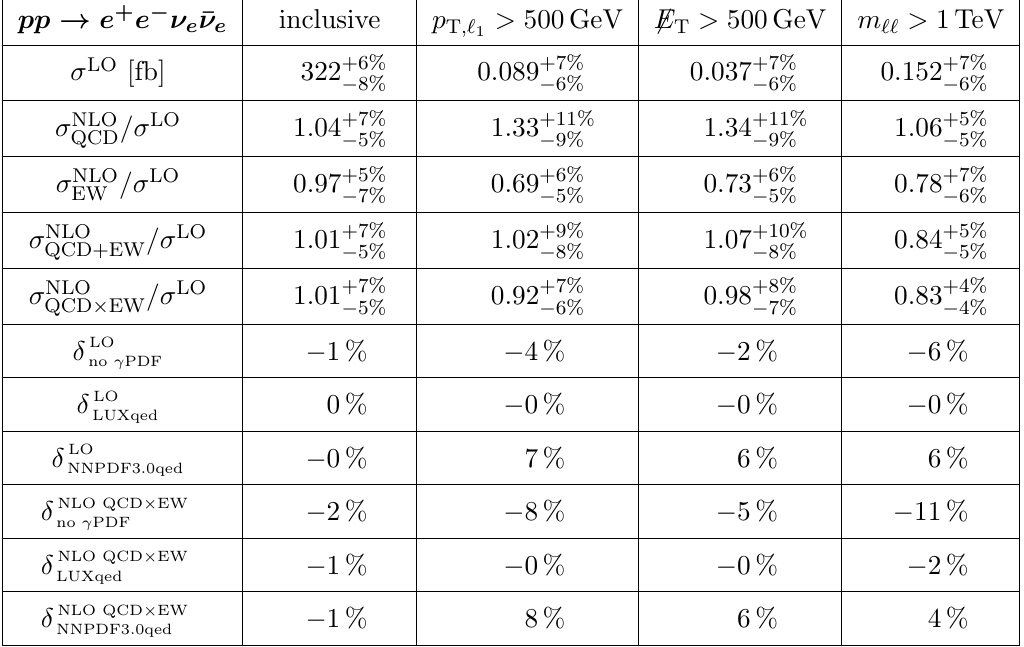
Table 7 . Cross-sections for pp e + e (cid:0) (cid:23) e (cid:22) (cid:23) e at 13 TeV. Higher-order corrections, scale uncertainties ! and photon-induced contributions are presented as in table